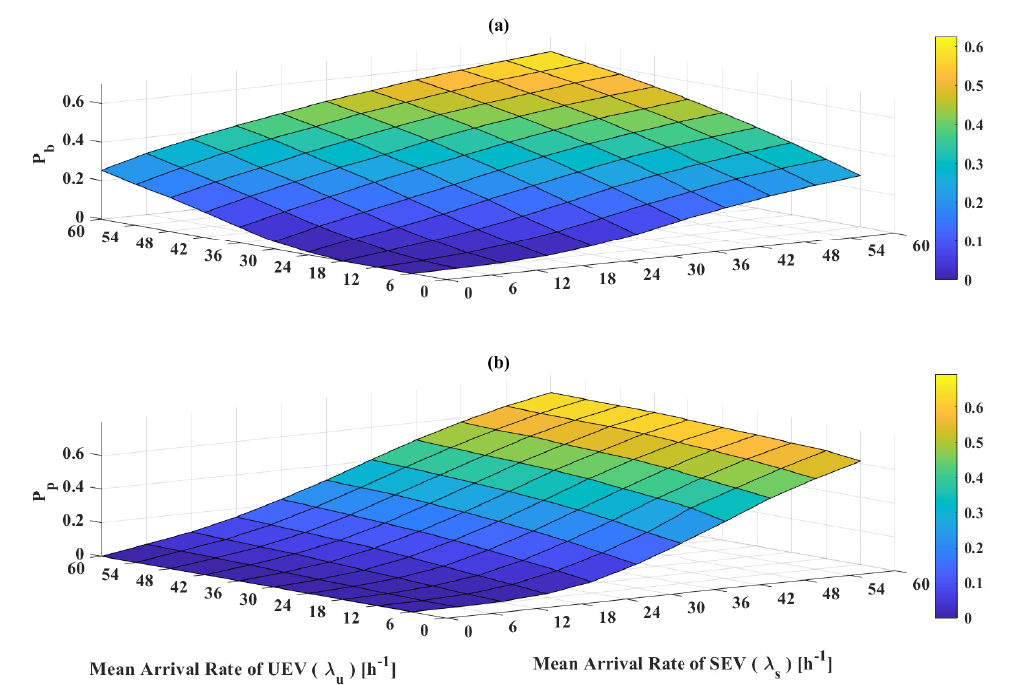
Figure 7. ( a ) Blocking and ( b ) preempting probability of UEVs with λ s and λ u